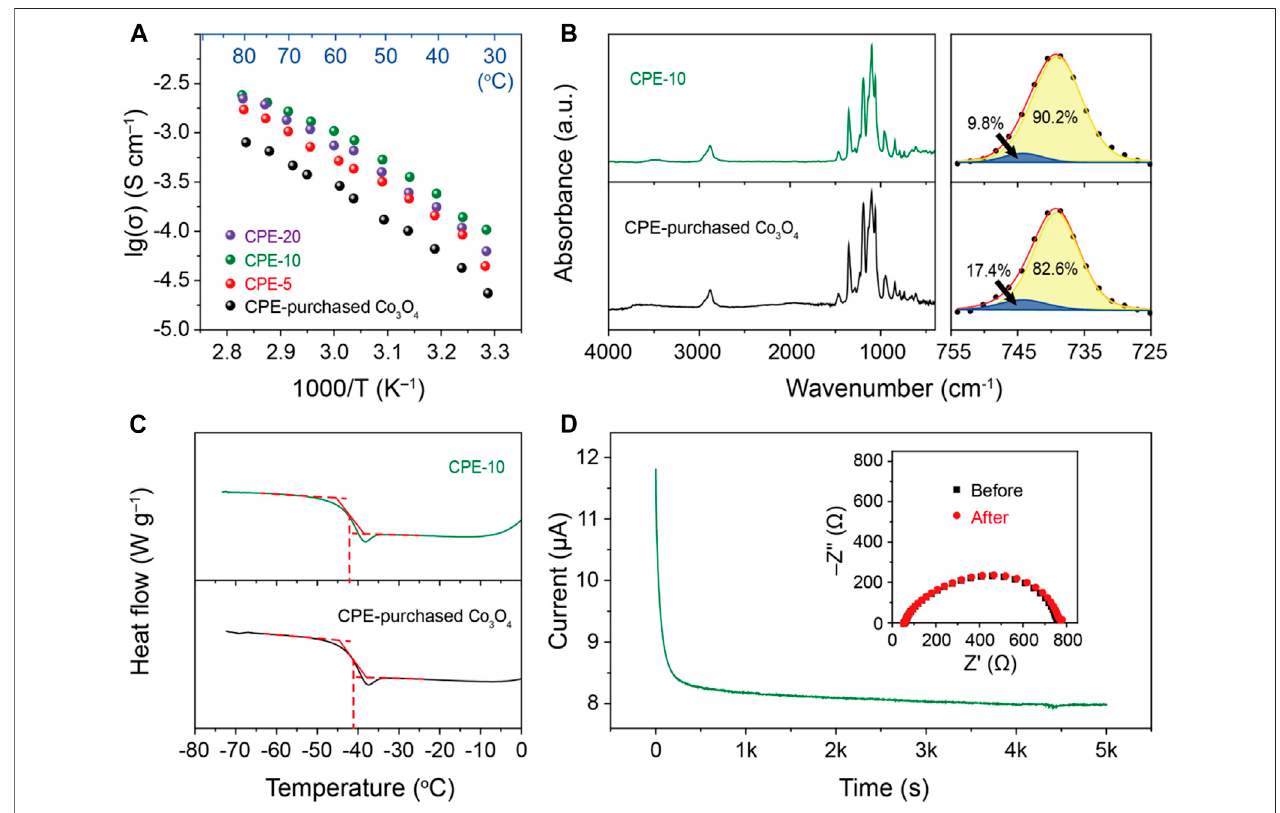
FIGURE 3 | The schematic diagram of the Li + transport paths in the CPE-10 and CPE-purchased Co 3 O 4 .